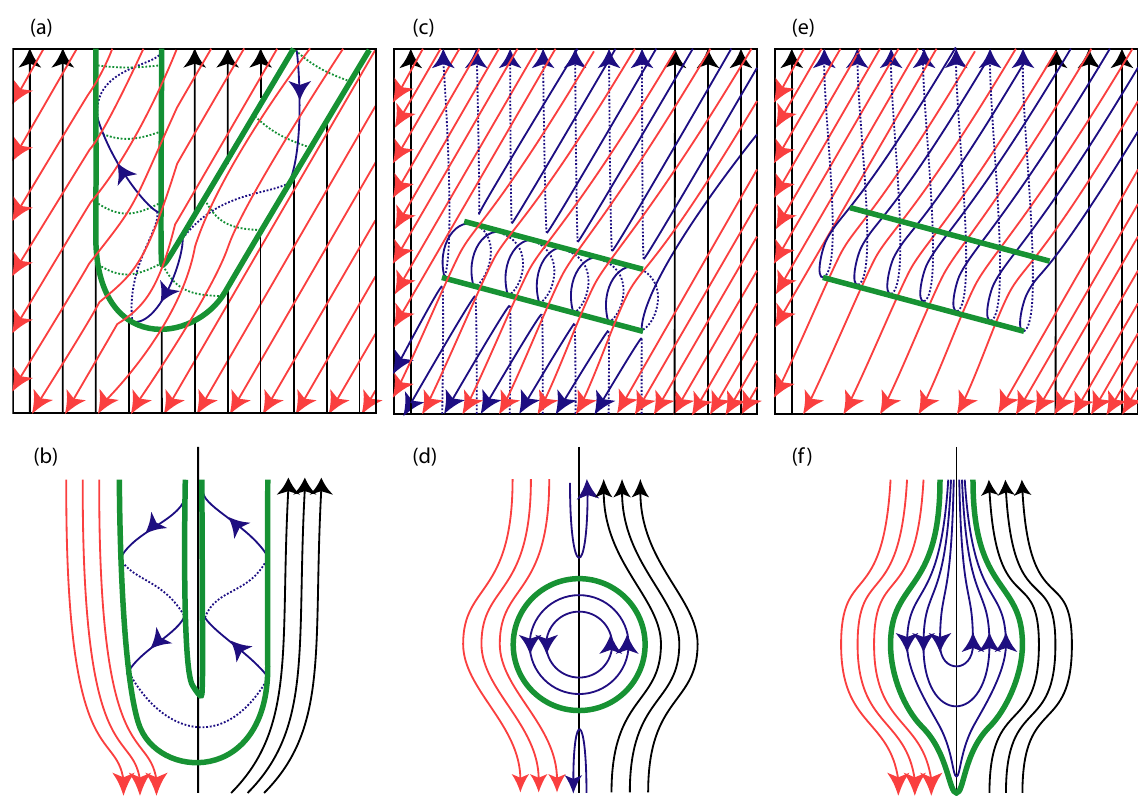
Fig. 1. Three different FTE models, sketched for a magnetosheath magnetic field clock angle of 150 ◦ . The sketches show: ( a and b ) the Russell and Elphic (1978, 1979) flux tube model, including the internal helical magnetic field explained by Sonnerup (1987); ( c and d ) the multiple X-line model suggested by Lee and Fu (1985) and ( e and f ) the bursty reconnection single X-line model developed independently by Scholer (1988a) and Southwood et al. (1988). Black and red lines represent unreconnected magnetospheric and magnetosheath magnetic field lines respectively; blue lines represent reconnected magnetic field lines. The edge of the FTE is marked in green. The top row shows views along an axis normal to the magnetopause surface, and the bottom row shows views tangential to the